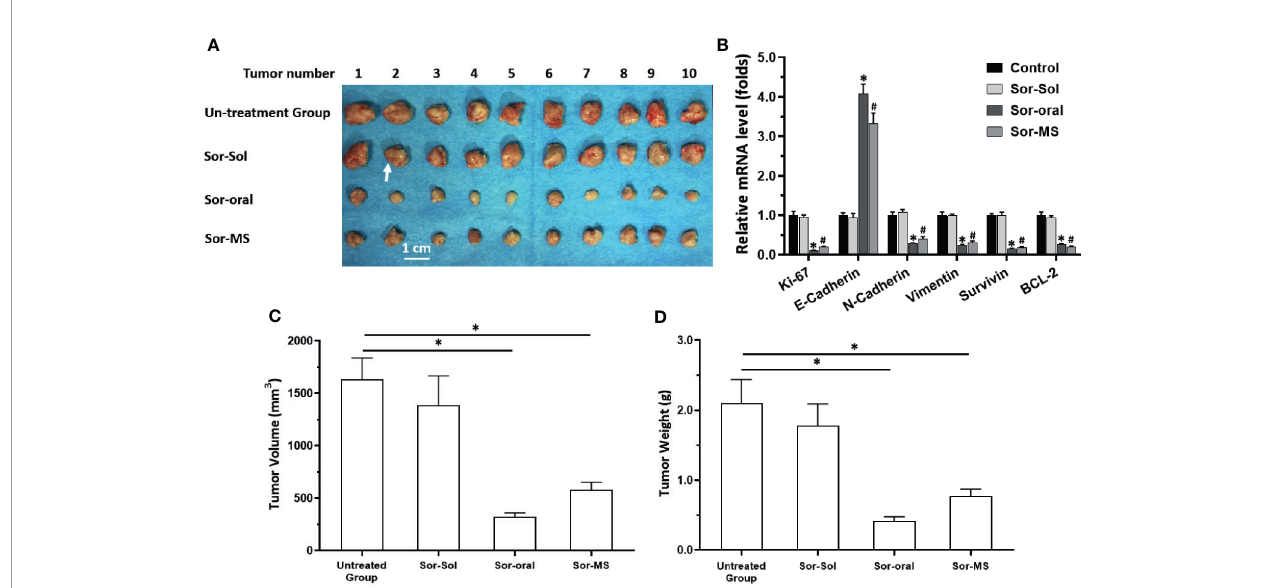
FIGURE 2 | Antitumor activation of sorafenib formulations in a subcutaneous tumor model in nude mice. MHCC97-H cells were cultured and injected subcutaneously into nude mice. Mice received one intratumor injection (50 m l amount) of sorafenib solution (Sor-Sol) (2mg/ml concentration), one intratumor injection (50 m l amount) of sorafenib microcrystal formulation with the largest particle-size (Sor-MS) (2mg/ml), or sorafenib via oral administration (2mg/kg dose, repeatedly over a long period of time). Results are shown as images of subcutaneous tumor tissues (A) , the expression level of proliferation-related factors in the tissues (B) , tumor volumes (C) , and tumor weights (D) . *P < 0.05 versus untreated group with Sor-Oral group; # P < 0.05 versus untreated group with Sor-MS group. The write arrow indicated the subcutaneous tumor